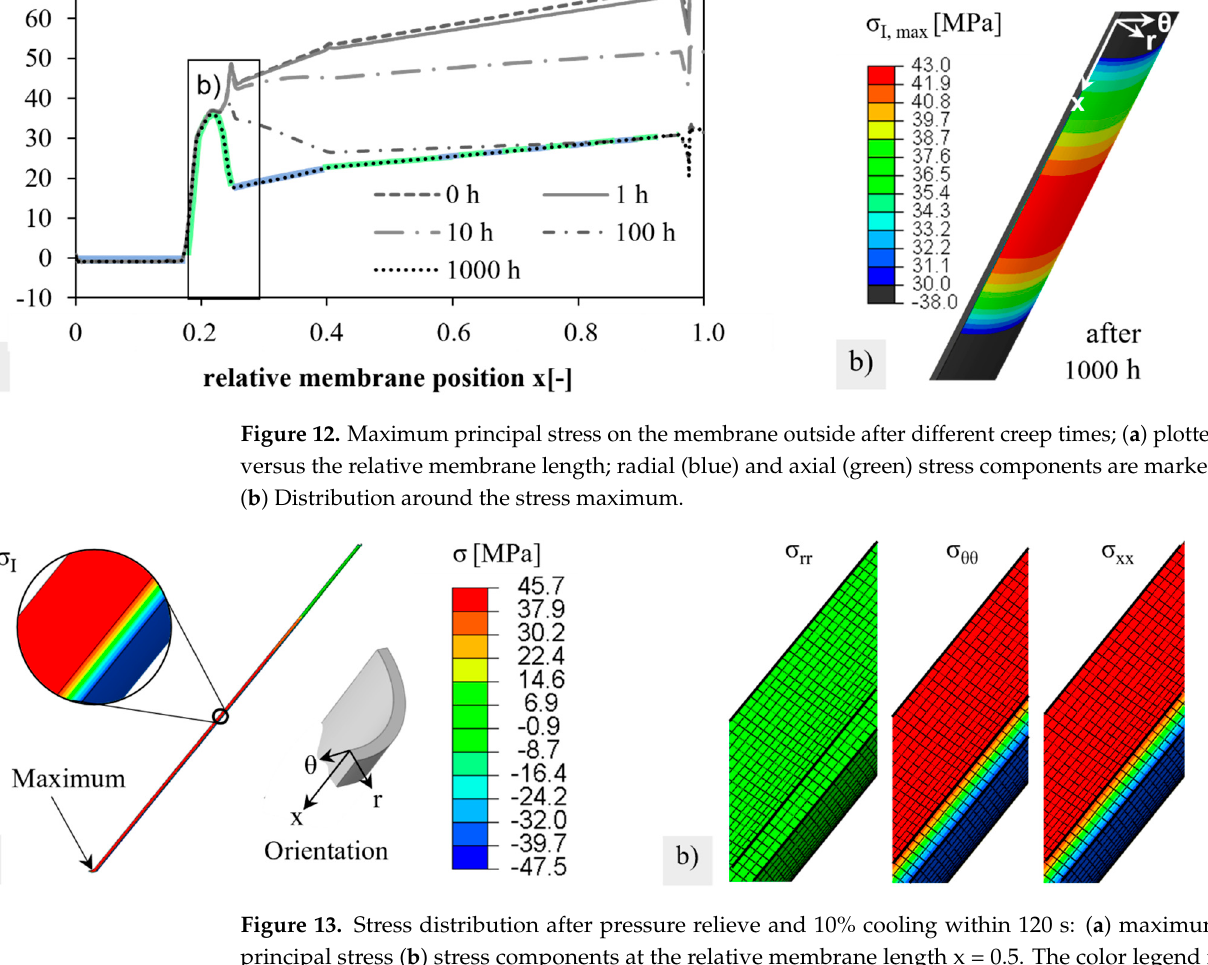
Figure 12. Maximum principal stress on the membrane outside after different creep times; ( a ) plot- ted versus the relative membrane length; radial (blue) and axial (green) stress components are marked. ( b ) Distribution around the stress maximum.